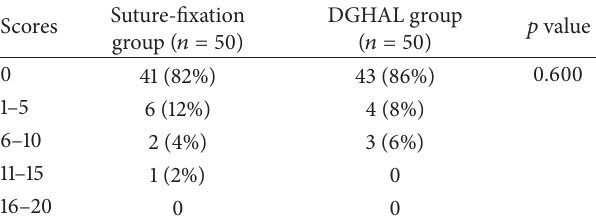
Table 3: Total scores of the Wexner Incontinence Grading